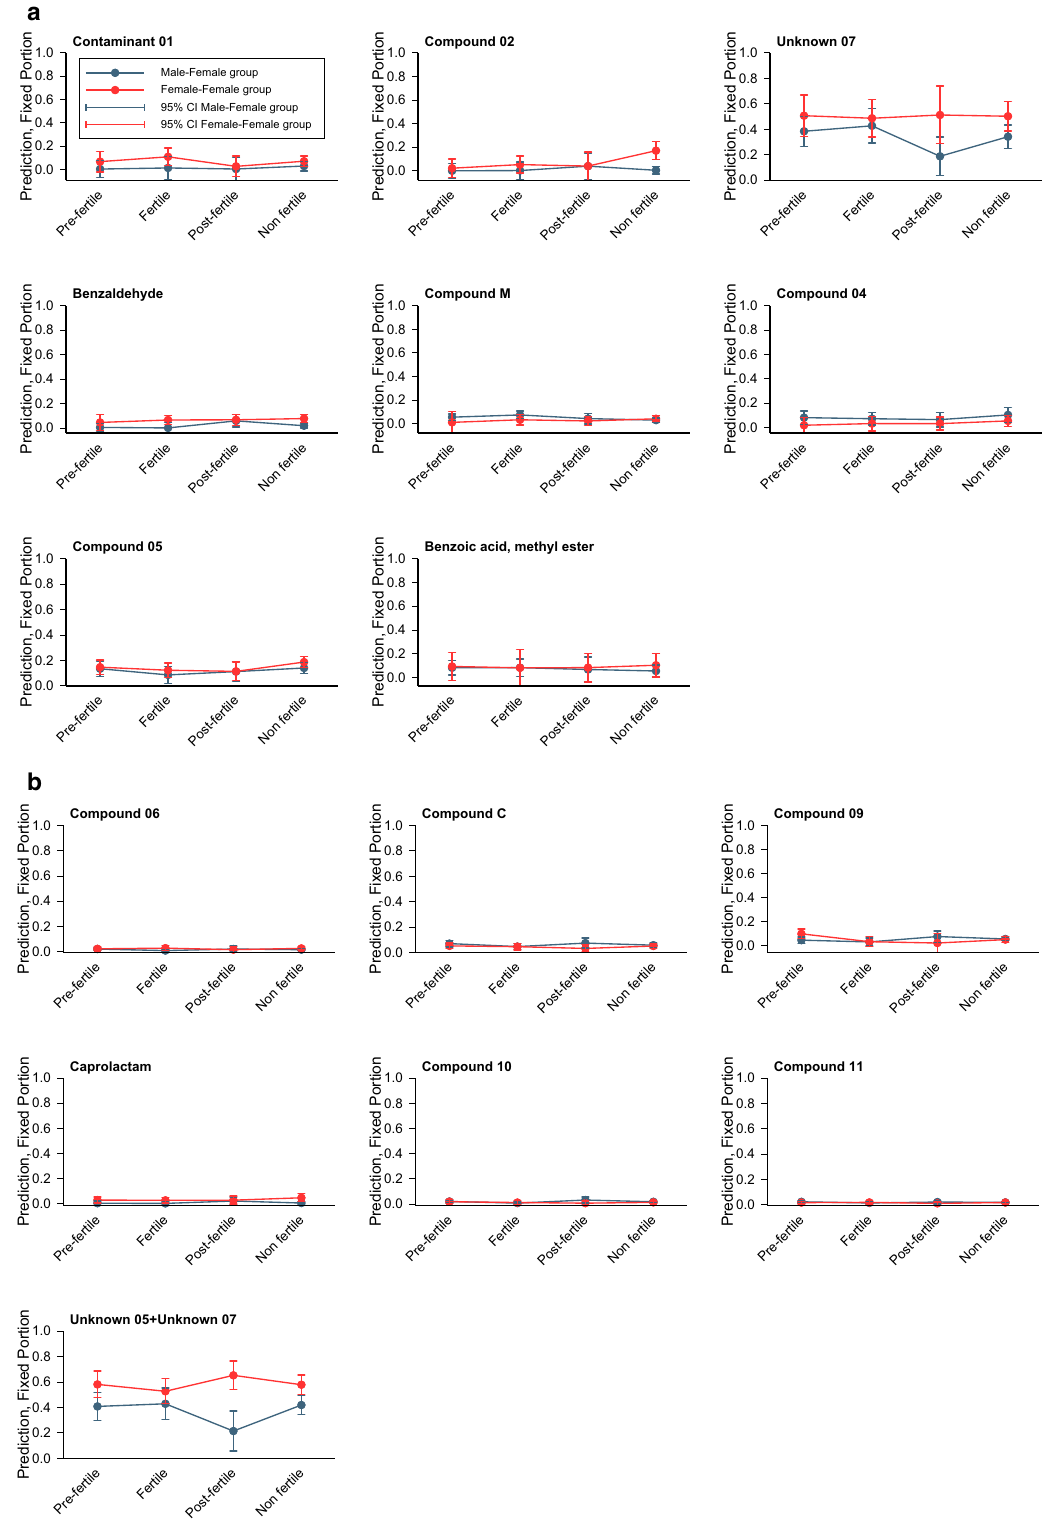
Figure 8. Predictions among the 15 individual compounds with measurements above the third quartile of the distribution for FF and MF separately by using GLMMs. No compounds differed significantly between fertile and non-fertile